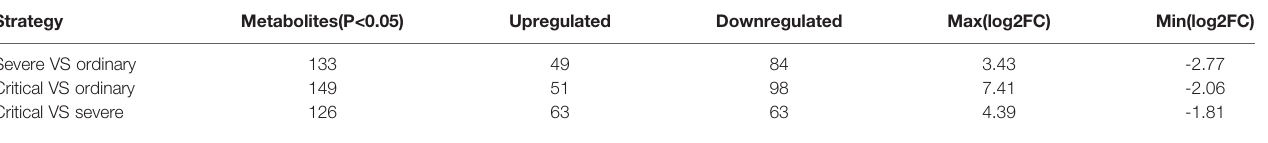
TABLE 2 | Metabolomic alternations as COVID-19